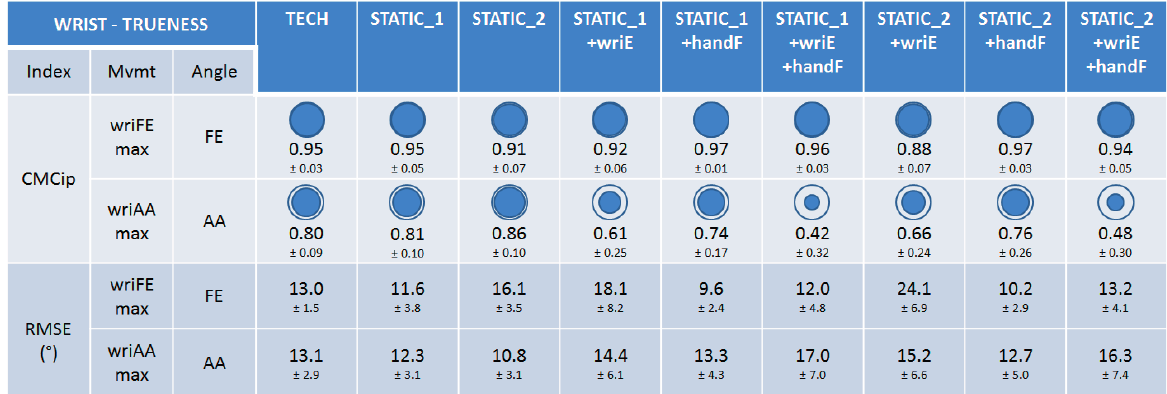
Figure 5. The results on trueness for the wrist joint. CMCip and RMSE values are reported for the different calibrations during maximal wrist flexion-extension (wriFEmax) and abduction-adduction (wriAAmax). For visual clarity, the CMCip mean value is completed with a proportional blue disc included in a blue circle that represents the optimal value